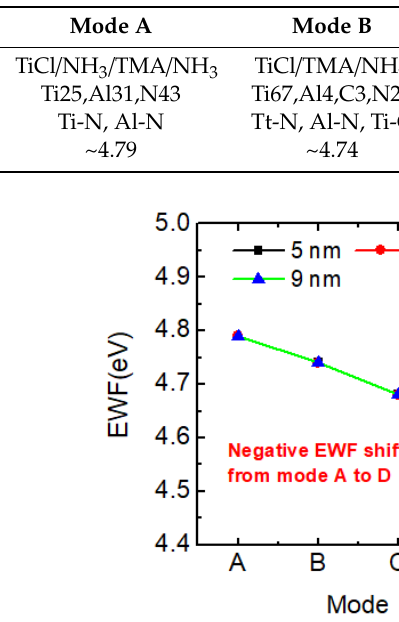
Table 1. The comparison of the ALD sequence and properties of and TiAlX.